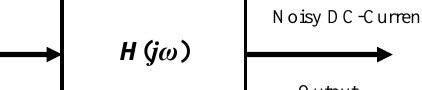
Where the transfer function can be given with a ra- tio defined between the input and output pair in the fre- quency domain.